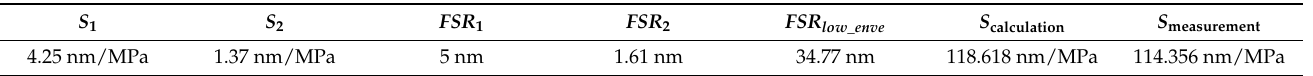
Table 2. The relevant parameters, measurement sensitivity, and calculation